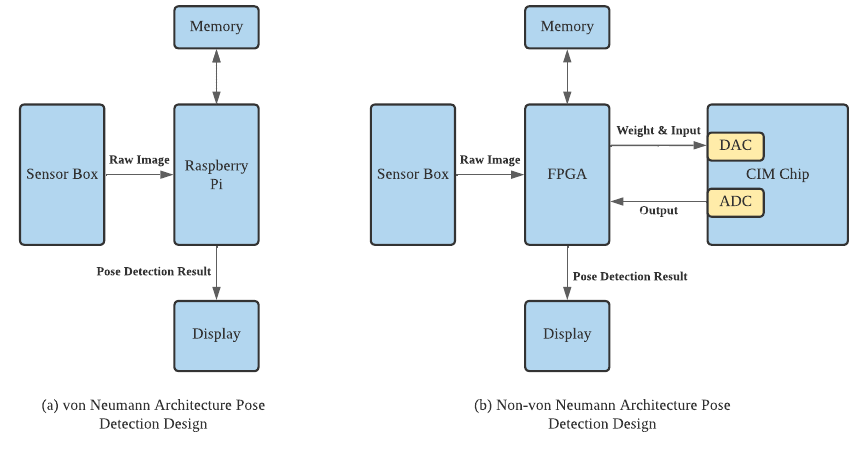
Figure 2. The von Neumann and CIM Architecture for Thermal Image